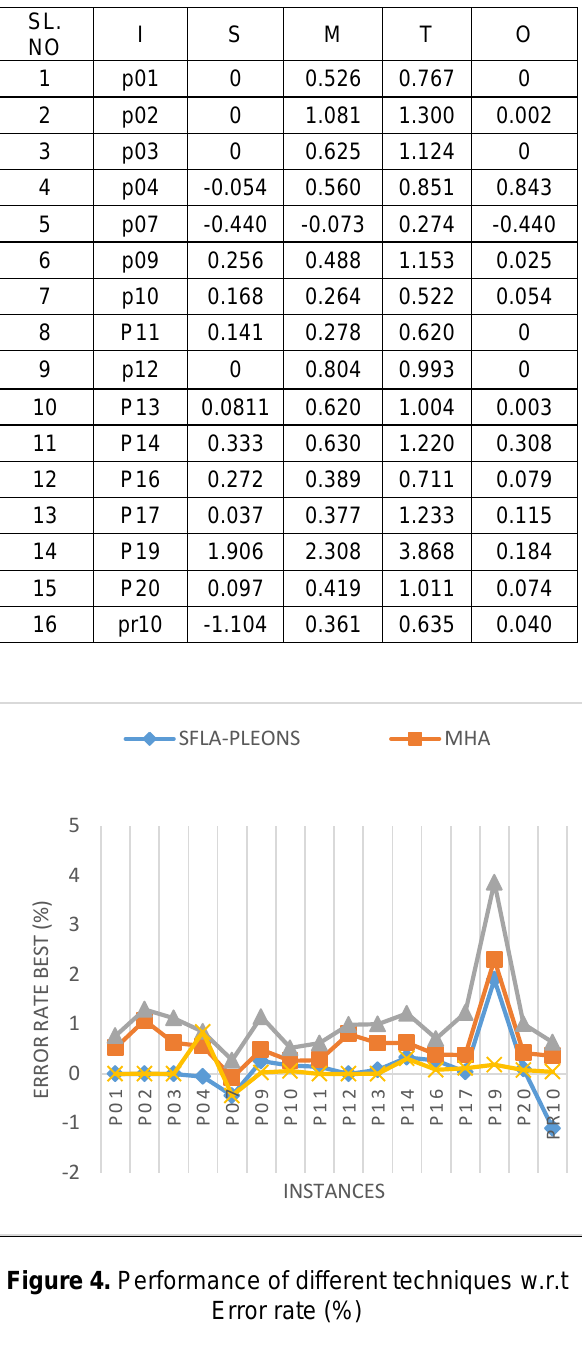
Table 3. Experimental results w.r.t Error rate (%) SL.